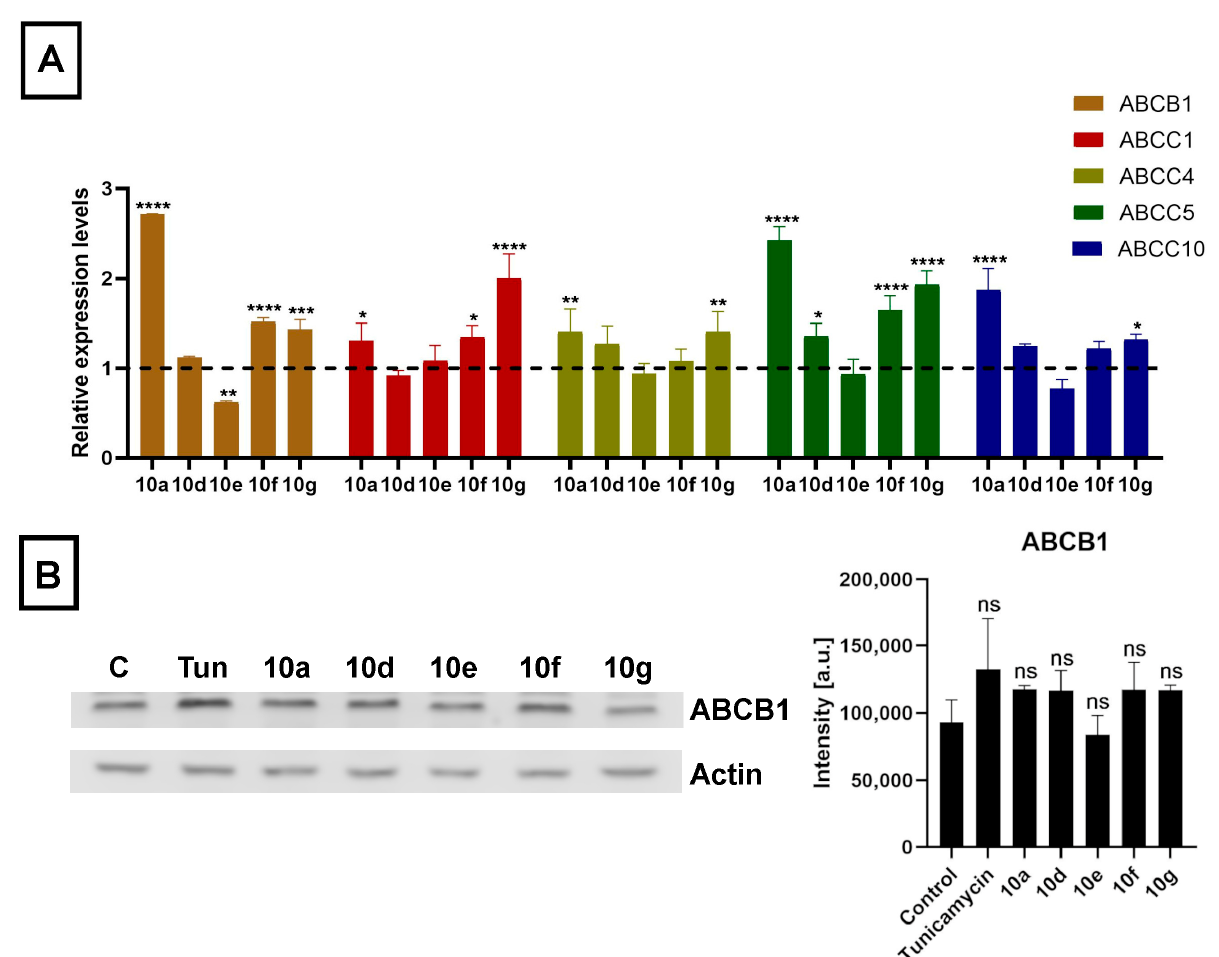
Figure 6. Acetylated androstano-arylpyrimidines do not suppress the efflux activity of multidrug- resistant cells by attenuating the expression of ABC transporters. ( A ) Relative mRNA levels of selected ABC transporters in Colo 320 cells treated with acetylated androstano-arylpyrimidines 10a , 10d , 10e , 10f, and 10g (in 20 µ M concentration for 24 h) determined by RT-qPCR measurements and subsequent analyses by the ΔΔ Ct method using GAPDH as the reference gene. For primer sequences and concentrations, please refer to Supplementary Material Table S3. ( B ) Representative Western blot images and densitometric analysis of ABCB1 protein levels in Colo 320 cells following exposure to androstano-arylpyrimidine acetates (treatment with steroid compounds at 20 μ M for 24 h) or Tunicamycin (600 nM, 24 h). The equal loading of protein samples was verified by probing the membrane with an anti-actin antibody. C = Control, Tun = Tunicamycin. In both panels, bar graphs represent mean ± SD values. Fisher’s LSD test, *: p < 0.05, **: p < 0.01, ***: p < 0.001, ****: p < 0.0001 ns: non-significant.